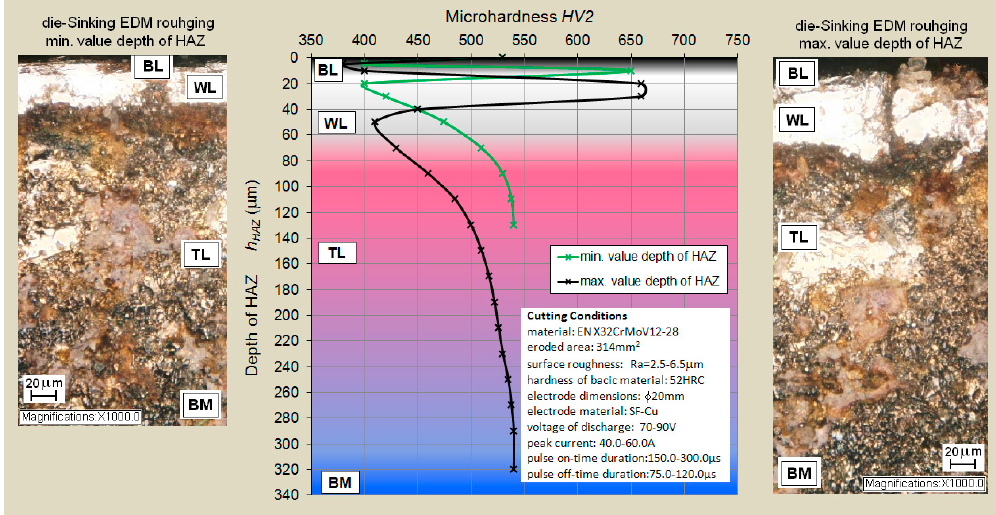
Figure 9. Boundary values of microhardness HV 2 recorded in particular HAZ layers (BL, WL, and TL) of tool steel EN X32CrMoV12 ‐ 28 after die ‐ sinking EDM roughing with a SF ‐ Cu